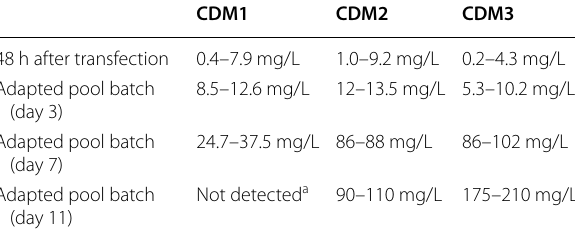
Table 3 Productivities after